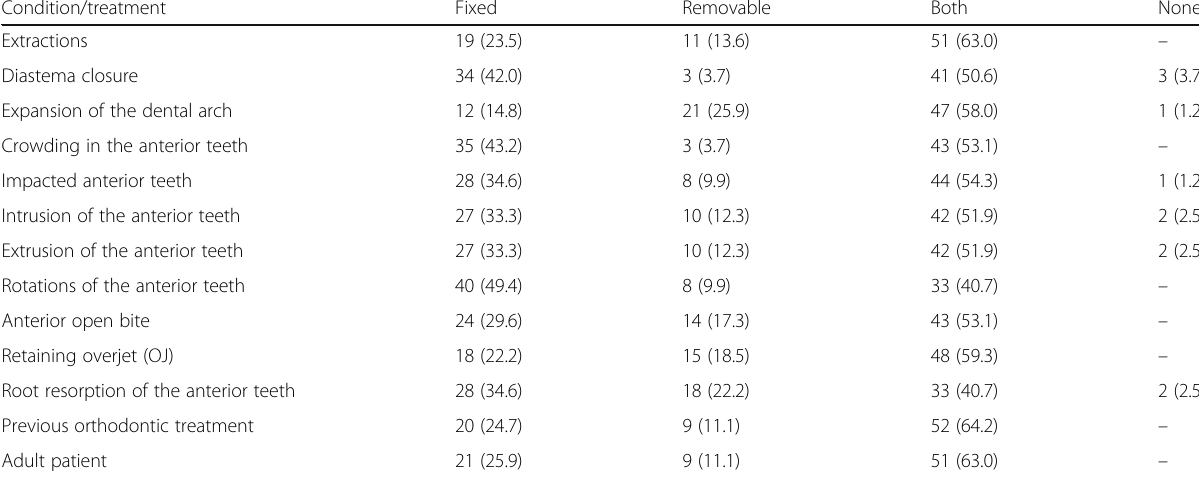
Table 2 Respondents who chose a certain retention in the lower dental arch depending on the condition or